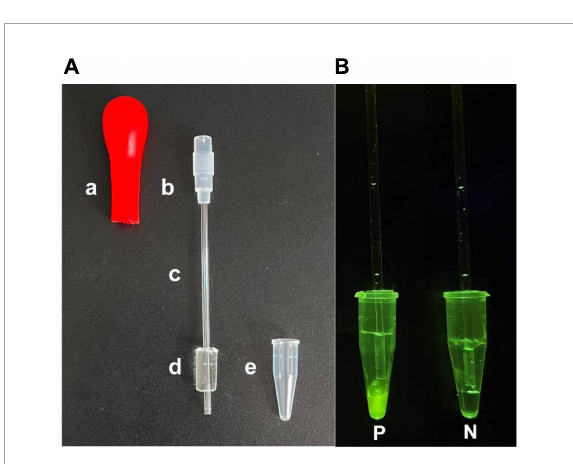
FIGURE2 The versatile integrated tube. The integrated tube consisted of five parts (A) , namely (a) rubber tip, (b) joint, (c) glass capillary, (d) PDMS plug and (e) PCR tube. Integrated tube based visual assay results (B) : P, positive; N,